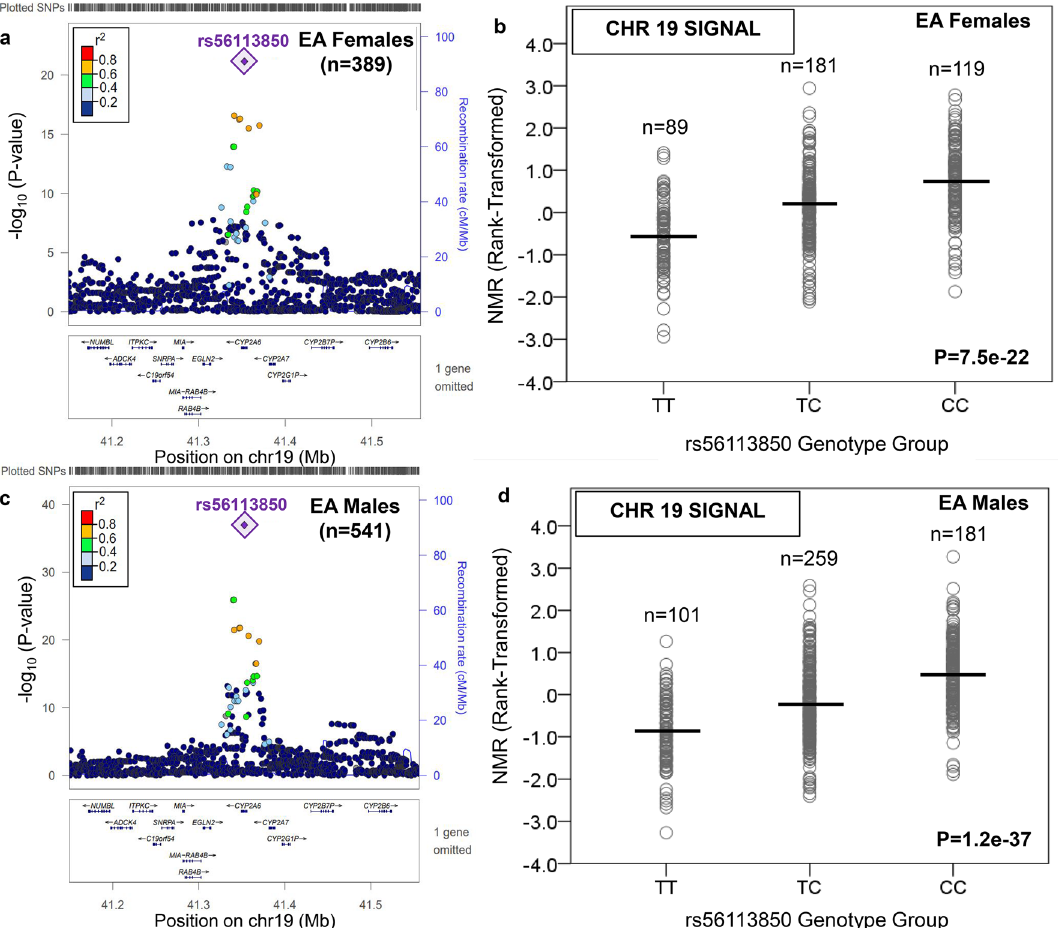
Figure 1. The top signal associated with the Nicotine Metabolite Ratio in European ancestry females and males was found on chromosome 19 in the region containing CYP2A6 . The nicotine metabolite ratio was rank- transformed for analysis. Regional plots, generated using LocusZoom 44 (freely available at locuszoom.org), show the top overall SNP in European American (EA) females (rs56113850) ( a ). The influence of rs56113850 on the Nicotine Metabolite Ratio (NMR) in EA females is shown in ( b ). The rs56113850 SNP was also the top SNP in EA males ( c ), and the influence of rs56113850 on the NMR in EA males is shown in d ). Linkage disequilibrium patterns in ( a ) and ( c ) are based upon the hg19/1000 Genomes November 2014 release European reference population. The plots in ( b ) and ( d ) were created using SPSS version 23 (can be purchased from IBM, Armonk, New York, USA). The black horizontal line represents the mean rank-transformed NMR in each group, and the P-value is from the GWAS after adjusting for population substructure and NMR